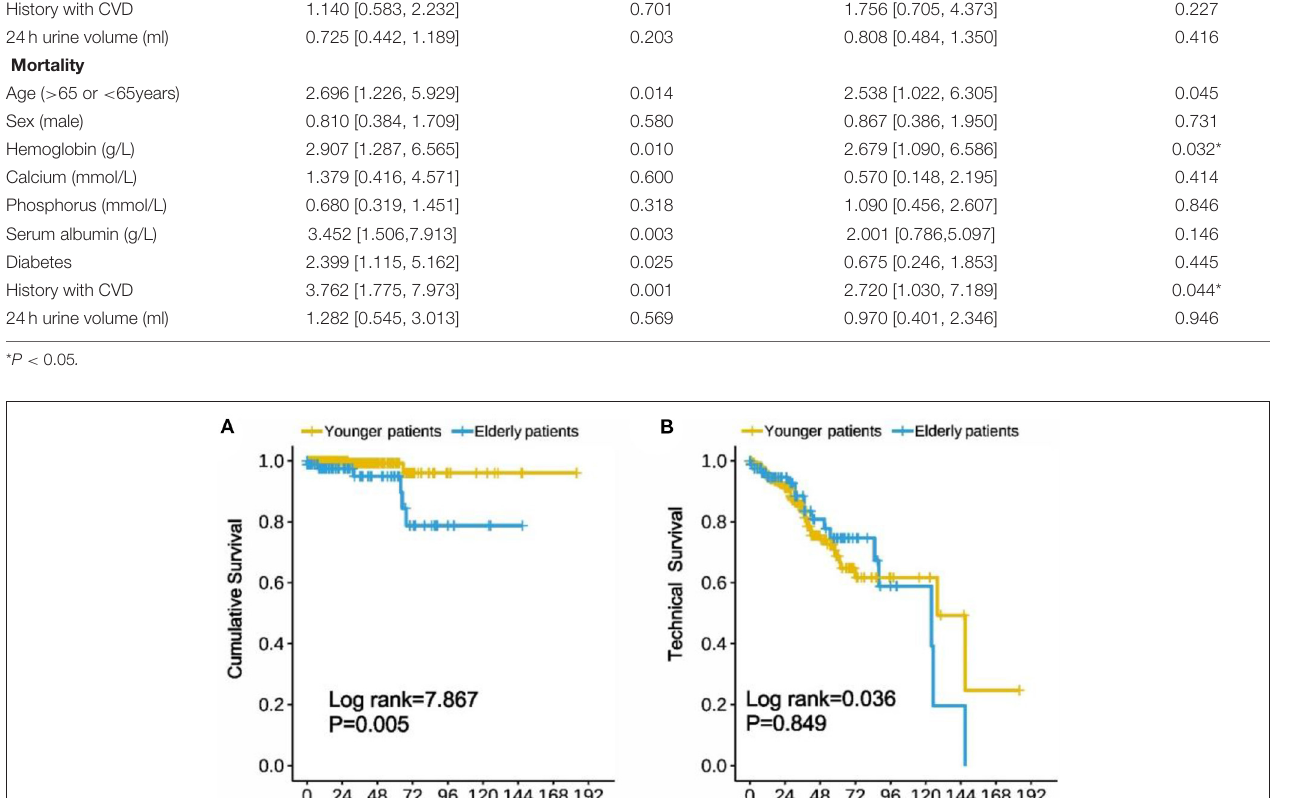
Frontiers in Medicine |